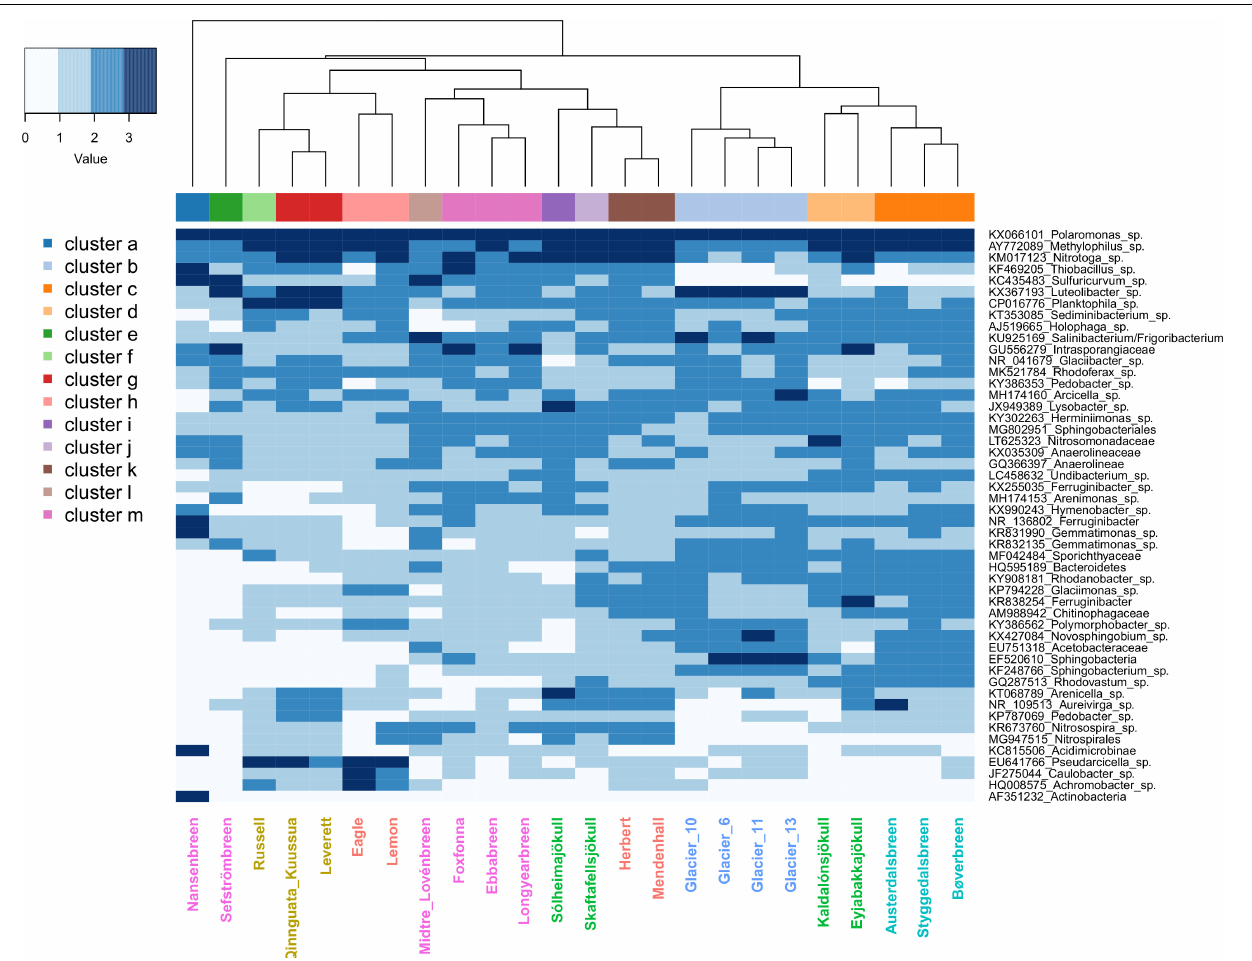
FIGURE 5 | Heatmap showing the log 10 + 1-transformed abundance of the top 50 OTUs averaged by glacier stream site for the full rarefied dataset. Higher values are indicated by greater shade intensity. Site labels are colored by region, with Alaska sites indicated by red, the Greenland Ice Sheet (GrIS) by gold, Iceland by green, Norway by turquoise, Qeqertarsuaq by blue, and Svalbard by purple. The column side bar indicates the 13 significant site